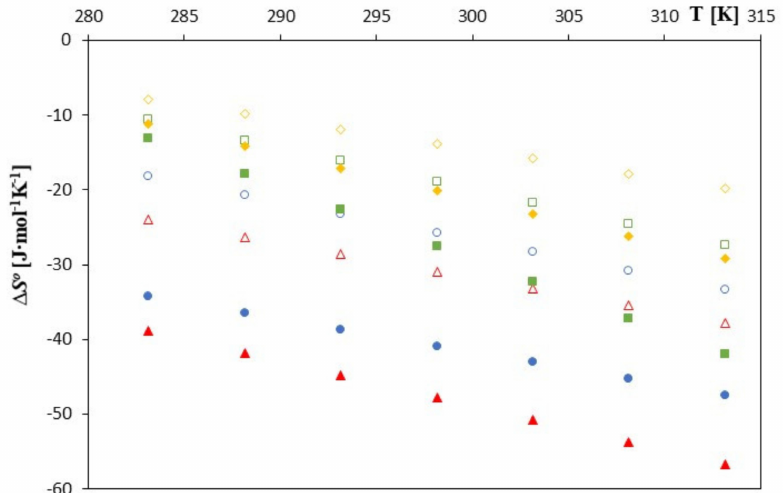
Figure 4. The plots of the dependence ∆ S 0 [J · mol − 1 ] in the function T [K] for β -cyclodextrin with all studied salts.: - trans -cinnamic acid; - trans –p-coumaric acid; - trans -caffeic acid; - trans -ferulic acid and 2-HP- β -cyclodextrin with the studied salts.: - trans -cinnamic acid; - trans –p-coumaric acid; - trans -caffeic acid; - trans -ferulic